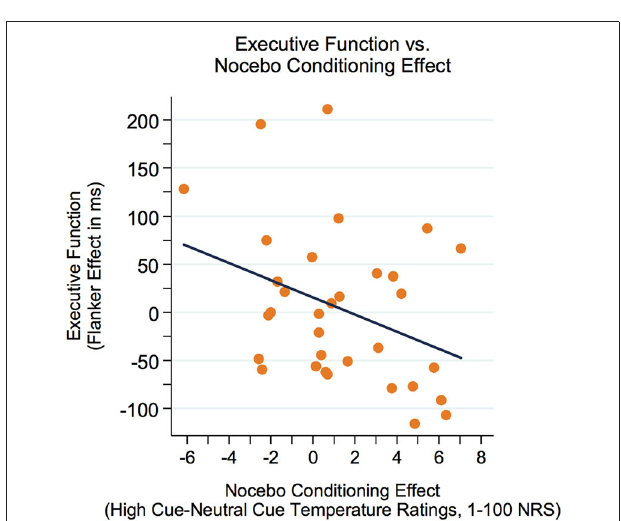
FIGURE 4 | The Flanker effect was negatively related to the nocebo-like effect ( r = − 0.36, p = 0.042), suggesting that adolescents with better executive function (lower Flanker effect) showed a higher nocebo-like effect. Better executive function = lower Flanker effect. NRS, numeric response scale.